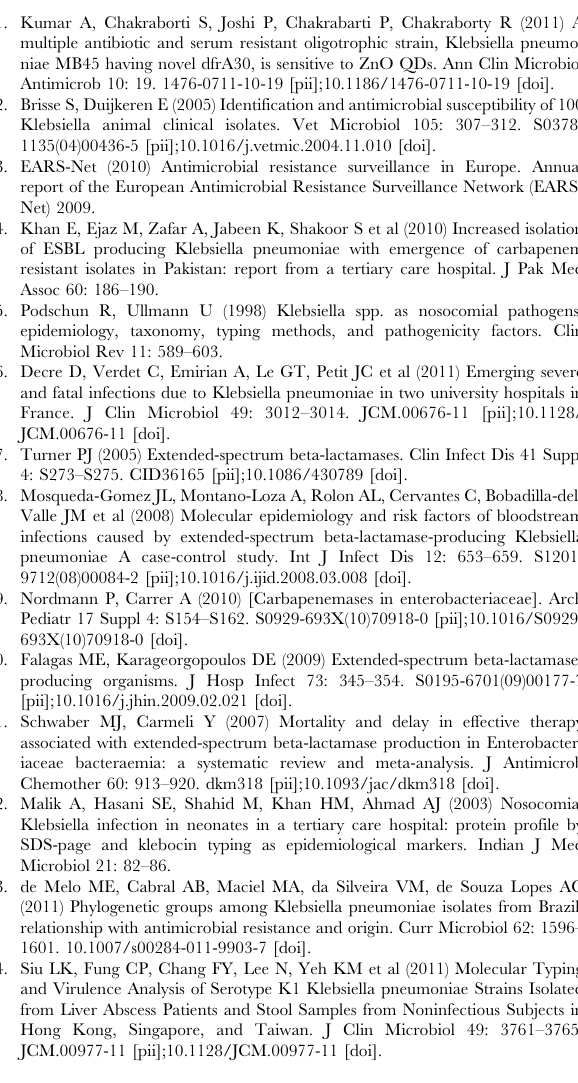
Table S1 Distribution of Klebsiella pneumoniae strains according to the dendrogram generated by BIOTYPER software (version 2, Bruker Daltonics) at the distance level of 500. Table S2 Comparison of the clusters obtained according to different cut-offs at 500, 180 and 100 of the dendrogram generated by BIOTYPER software (version 2, Bruker